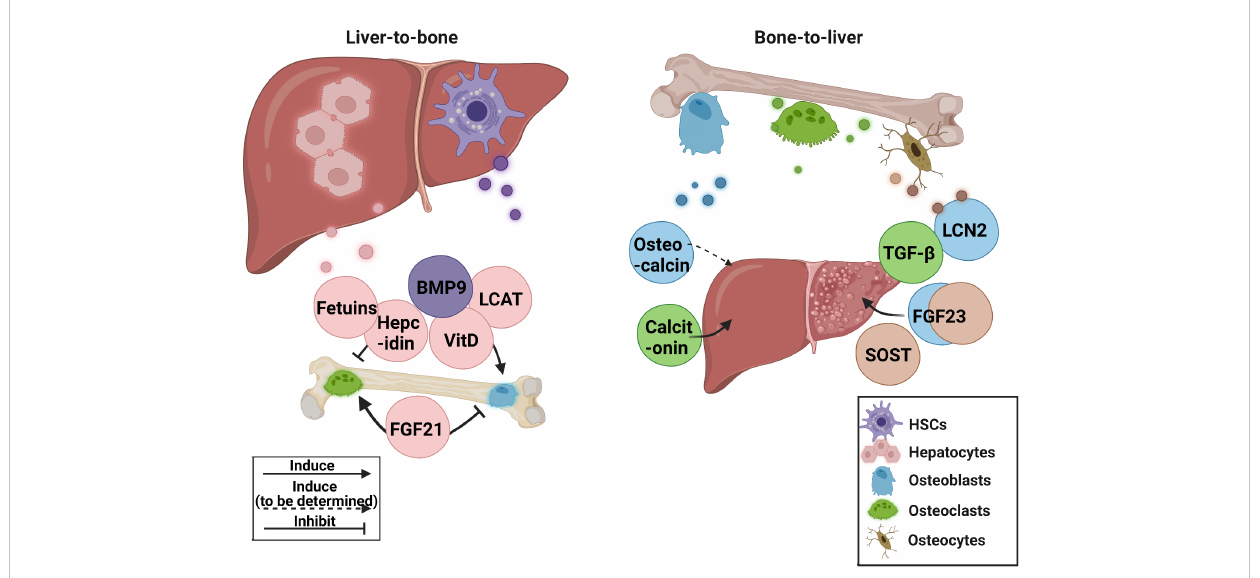
FIGURE 1 The current research status of related hepatokines and osteokines. BMP9, bone morphogenetic protein 9; FGF21, fi broblast growth factor 21; FGF23, fi broblast growth factor 23; HSCs, hepatic stellate cells; LCN2, lipocalin 2; LCAT, lecithin cholesterol acyltransferase; SOST, sclerostin; TGF- b , transforming growth factor b ; VitD, vitamin